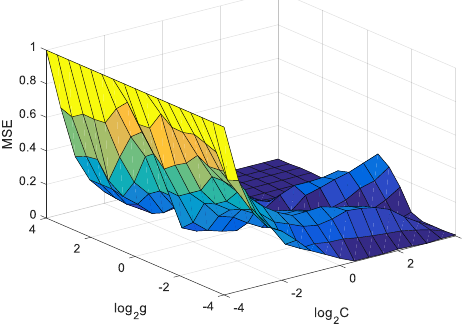
Figure 9. 3D plot of support vector machine (SVM) parameters.